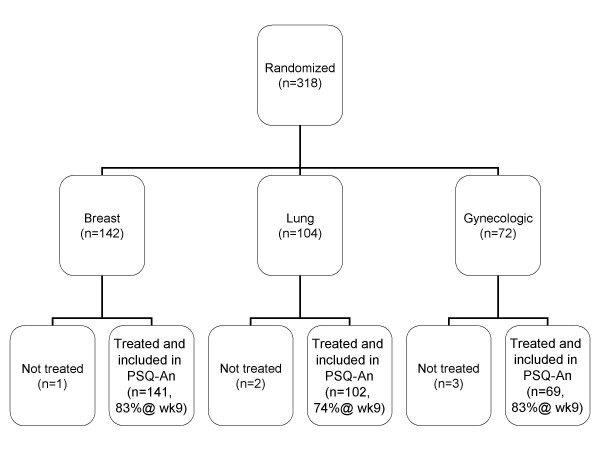
Patient Flow Diagram. Initial sample sizes and proportion remaining at week 9 shown.